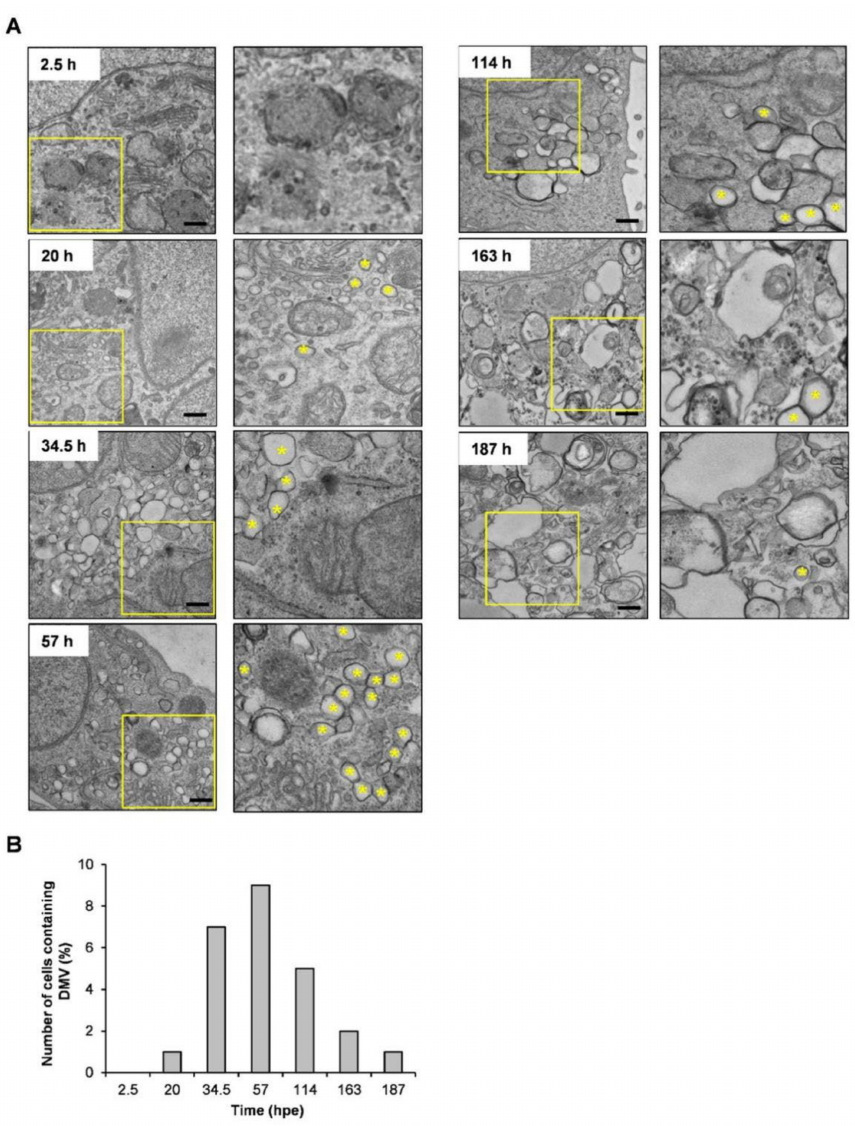
Figure 3. Time course of membrane alterations after electroporation of HCV replicon RNA. ( A ) HuH- 7T1 cells were electroporated with SGR-JFH1/WT/SLG RNA, subjecting to TEM analysis at the indicated time points post-electroporation. Double-membrane vesicles (DMVs) in the box with yellow lines are marked with yellow asterisks. Scale bars: 400 nm. ( B ) Number of cells containing DMVs (at least one DMV) was counted in the photos taken by TEM at the indicated time